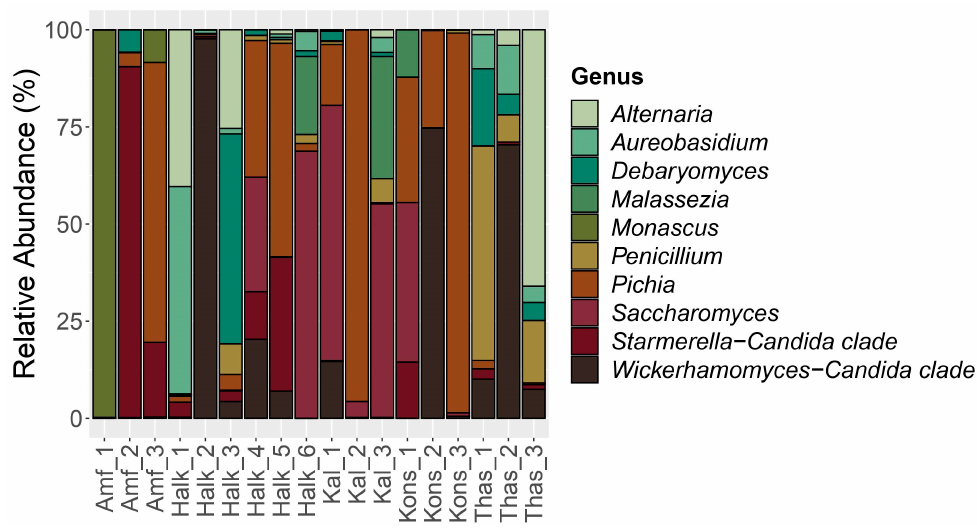
Figure 3. Distribution of the major fungal genera detected in the samples. The scale in the y-axis reflects the normalized relative abundance percentages (%).